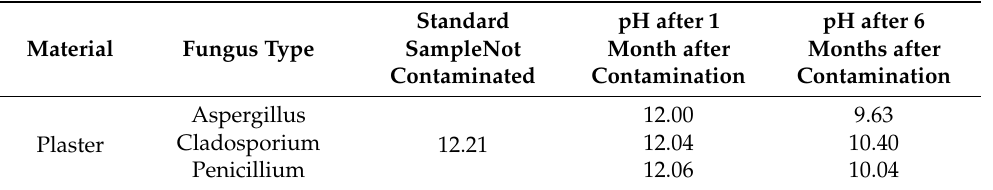
Table 1. Determined pH values for plaster based on the fungus type and test date (own table based on